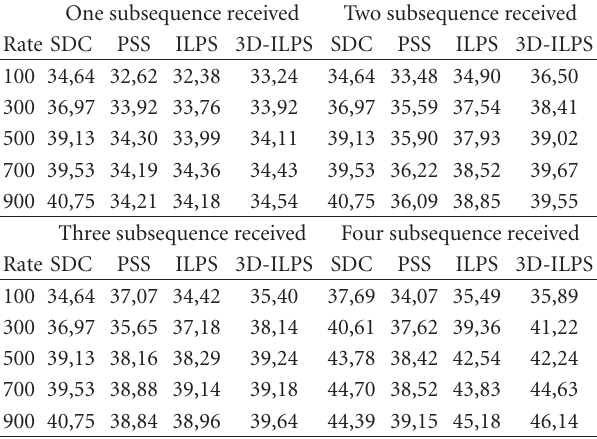
Table 2: Performance of depth view, Ballet, 10% packet loss.